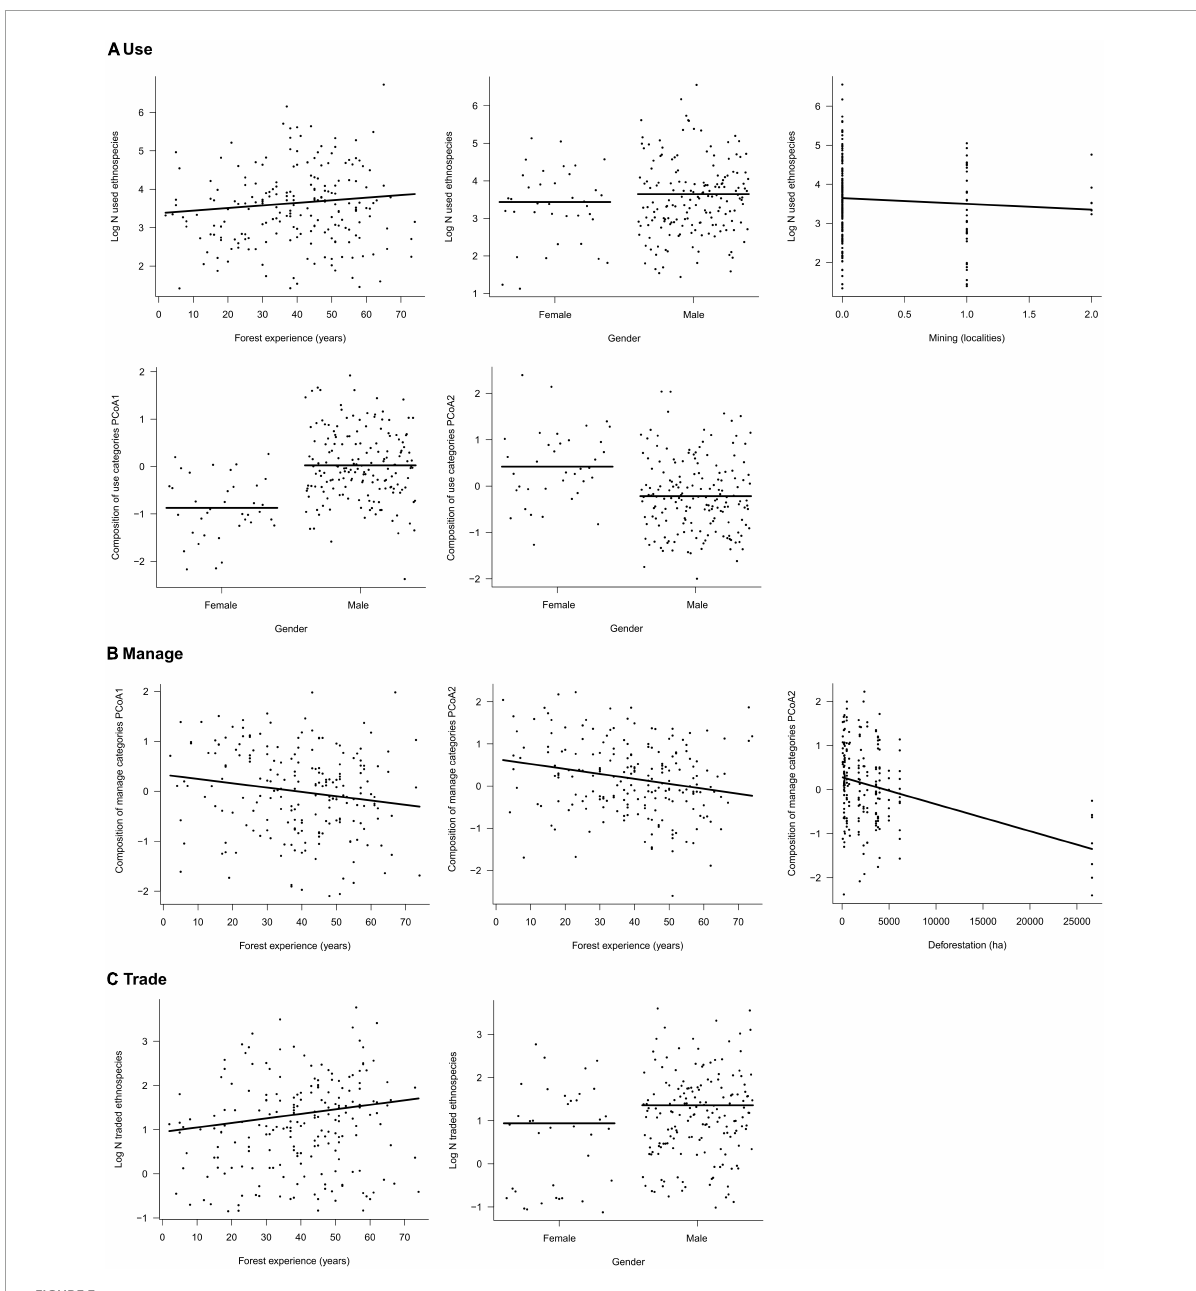
FIGURE3 Partial residual plots between variables that are statistically significant in linear models: (A) used ethnospecies richness, composition of use category—PCoA1 and PCoA2; (B) relative abundance of management category—PCoA1 and PCoA2; (C) traded ethnospecies richness. Each point represents one individual; lines represent model predictions. The Y axis corresponds to partial residuals, and thus shows the relationship between a given dependent variable and a given predictor while controlling for the effects of remaining predictors in the